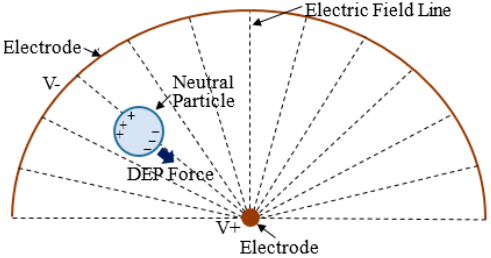
Figure 1. Dielectrophoresis (DEP) force on a neutral particle in a non-uniform electric field.